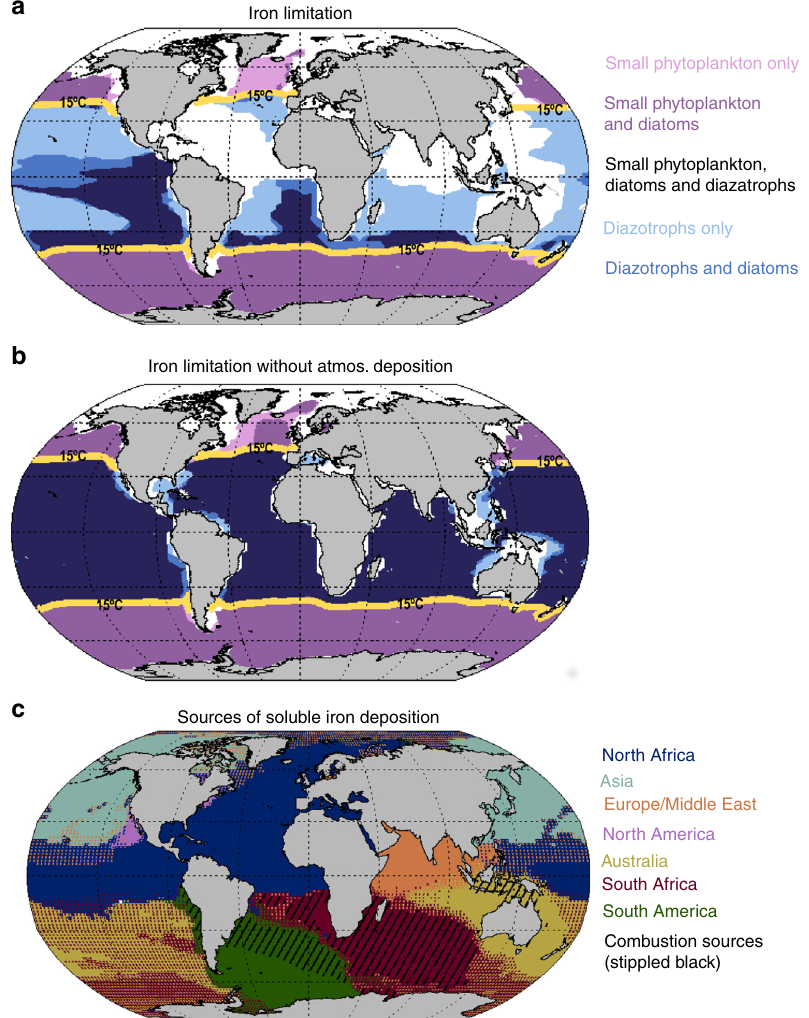
Fig. 1 Estimate of iron limitation regions and sources of soluble iron. Estimate of ocean iron limitation regions for diatoms, small phytoplankton, and diazatrophs, based on an ocean biogeochemistry model 161 ( a , b ); iron is limiting for small phytoplankton (light mauve); iron is limiting for diazotrophs and small phytoplankton (purple); iron is limiting for small phytoplankton, diatoms, and diazatrophs (deep purple); iron is limiting for diazatrophs (gray-blue); iron is limiting for diatoms and diazatrophs (blue). This is shown for the current climate ( a ), and in the current climate with no atmospheric deposition of iron ( b ). See Supplementary Figure 1 for more information. Overall, most of the world ’ s ocean depend on atmospheric iron inputs. Diazotrophs are not present in the model at high latitudes where temperatures are below ~15 °C. The solid yellow line represents the mean location of this temperature control on the diazotrophs. Model-based source apportionment ( c ) for soluble iron deposition into the oceans using R. Scanza et al. (manuscript in preparation) and ref. 160 . The dominant source for each region is identi fi ed by color (North Africa: dark blue; East Asia: light green; North America: pink; Australia: yellow; South Africa: red, South America: green). If the soluble iron is contributed substantially from two source regions, the colors are mixed with the dominant source providing the base color, and the secondary source the points. In regions where one source dominates, but the dominant source is not dust, but combustion, black diagonal stippling is applied (in the Southern Hemisphere, near Africa, South America and